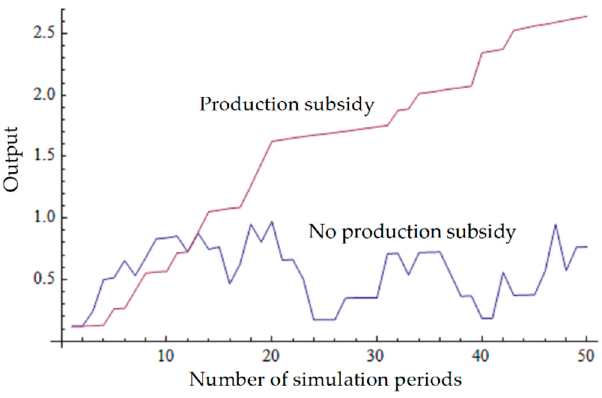
Figure 10. Impact of the production subsidy on the output.